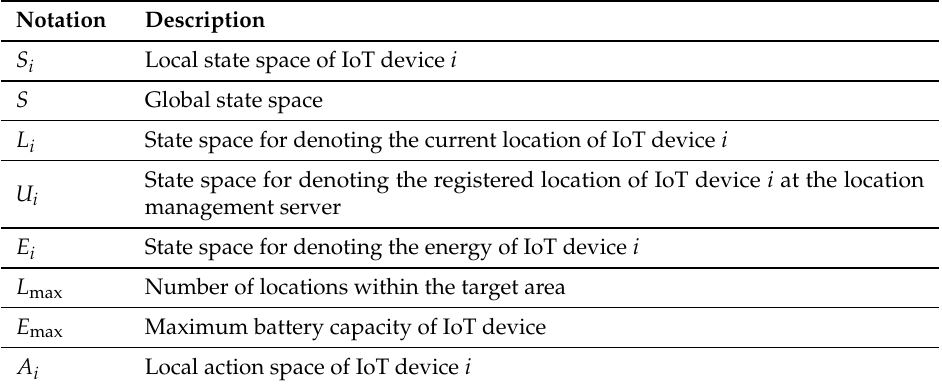
Table 1. Summary of